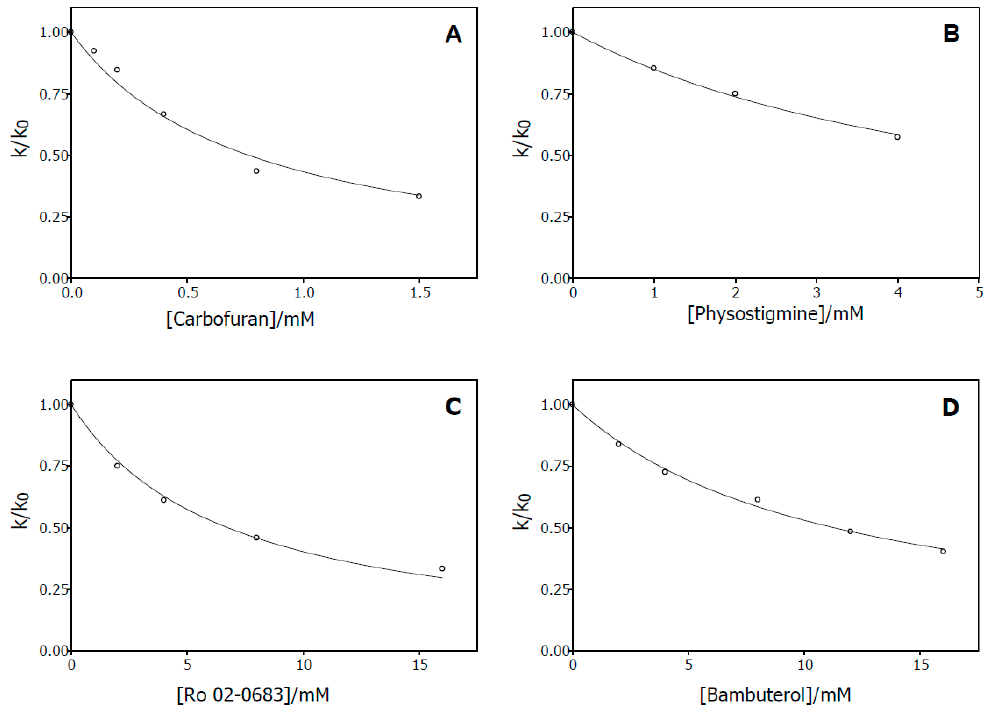
Figure 6. Dependence on inhibitor concentration of normalized k / k 0 values for carbofuran ( A ), physostigmine ( B ), Ro 02-0683 ( C ) and bambuterol ( D ). Lines represent theoretical curves calculated using Equation (5). Table 4. Reversible inhibition of rePON1 hydrolysis of PTA by selected carbamates ( K i ± standard error of mean) evaluated using the progress curves from at least three